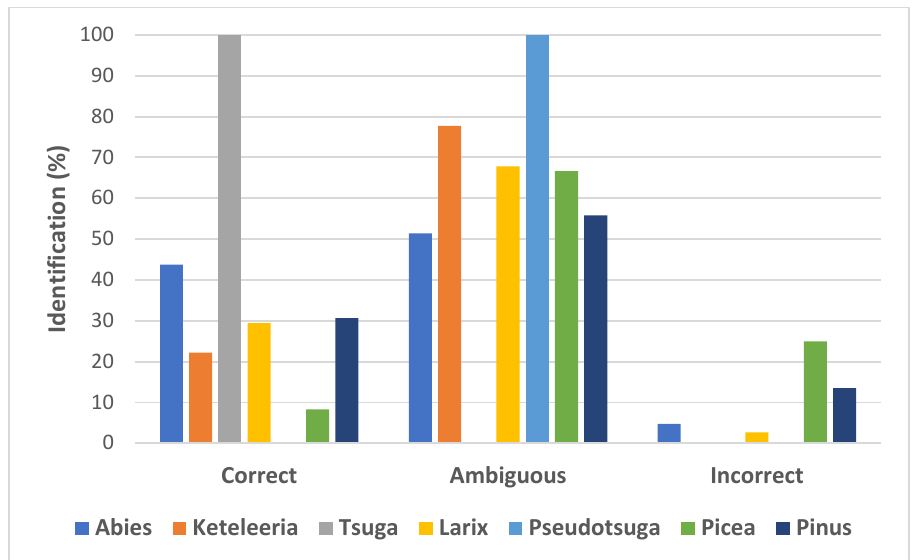
Figure 2. Species discrimination rates based on BLAST1 method.